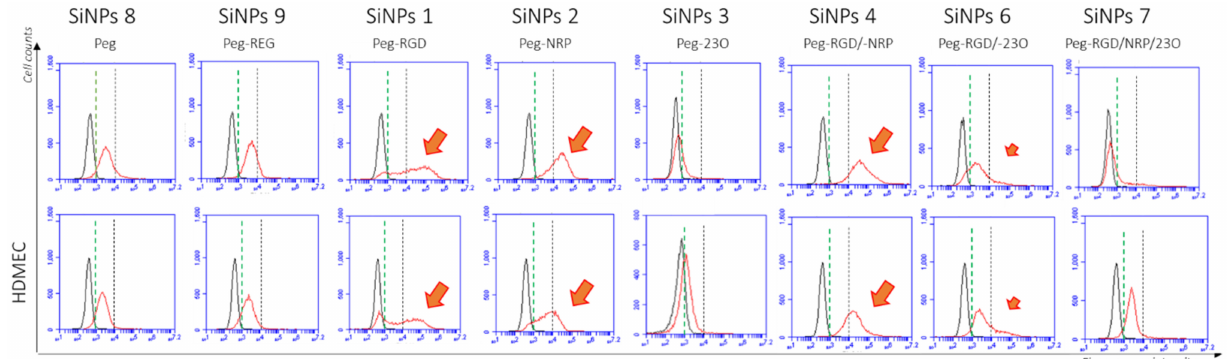
Figure 9. Binding efficiency on endothelial cells. HUVEC and HDMEC endothelial cells are expressing the α v ß 3 and NRP1 receptors. The binding efficiency of each type of SiNP was evaluated by flow cytometry after 30 min incubation in suspension with the cells. X -axis: Log. Fluorescence intensities. Y -axis: cell counts. Vertical dotted lines: max level of autofluorescence of the cells (green); max level of non-specific labeling with the SiNPs (black). Orange arrows indicate the presence of positively labeled cells and their size indicates the population of positively stained